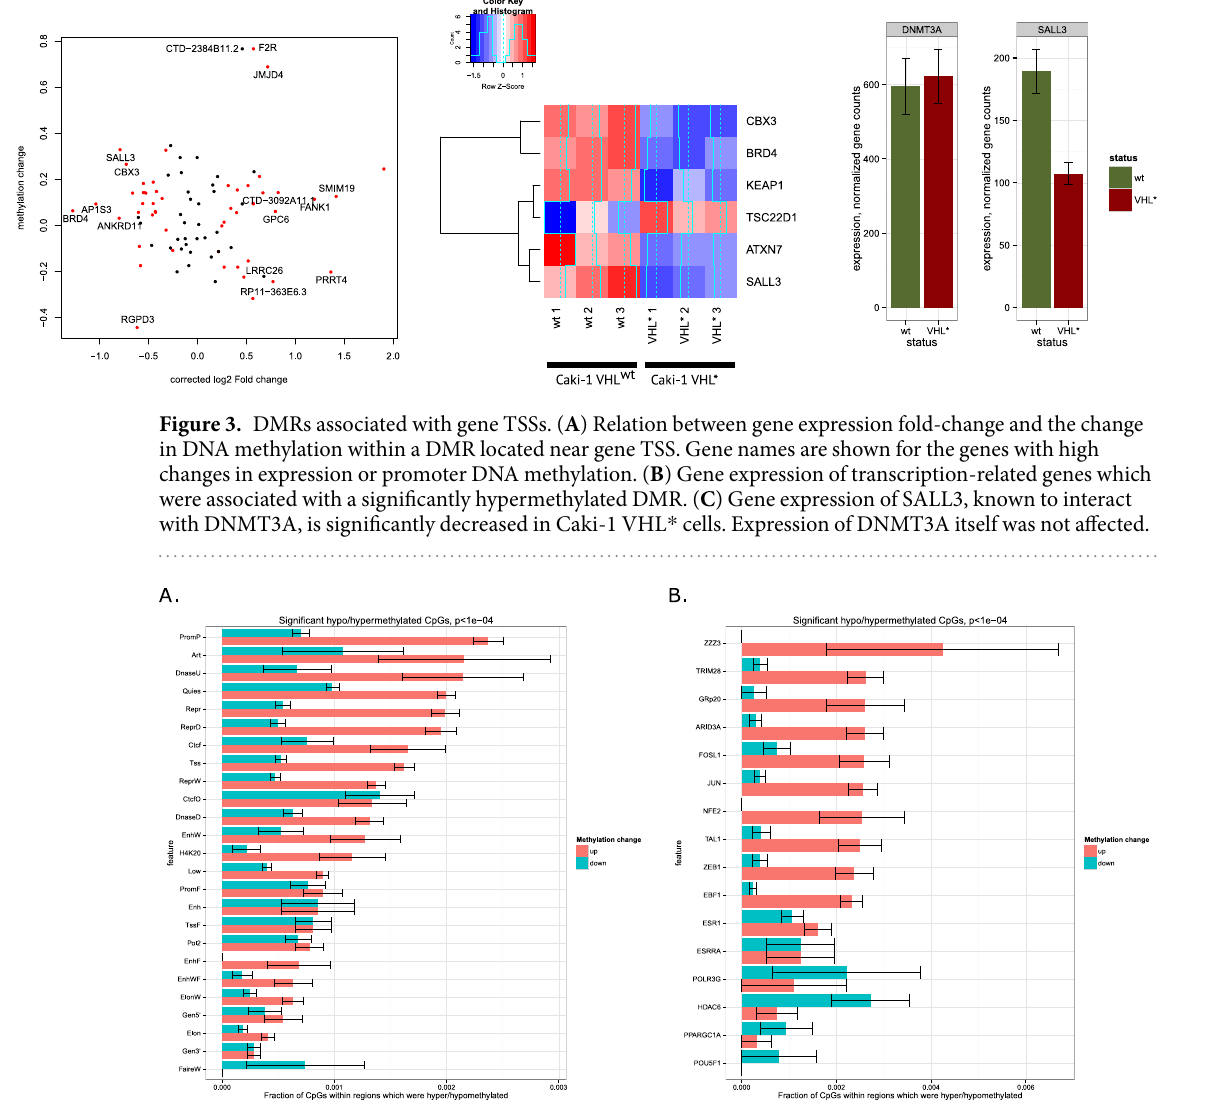
Figure 4. Distribution of hypo- and hypermethylated CpGs within certain epigenomic features. Fraction of significantly hypo- (blue bars) and hypermethylated (red bars) CpGs among all CpGs within a given set of genomic regions. ( A ) Regions of ChromHMM genome segmentation. ( B ). Transcription factor binding sites (only the sites with the highest hyper- and hypomethylation rates are plotted). CpGs that were significantly hypermethylated after VHL inactivation, were enriched in AP-1 (JUN/FOS) and TRIM28 binding sites. Hypomethylated CpGs were enriched in HDAC6 binding